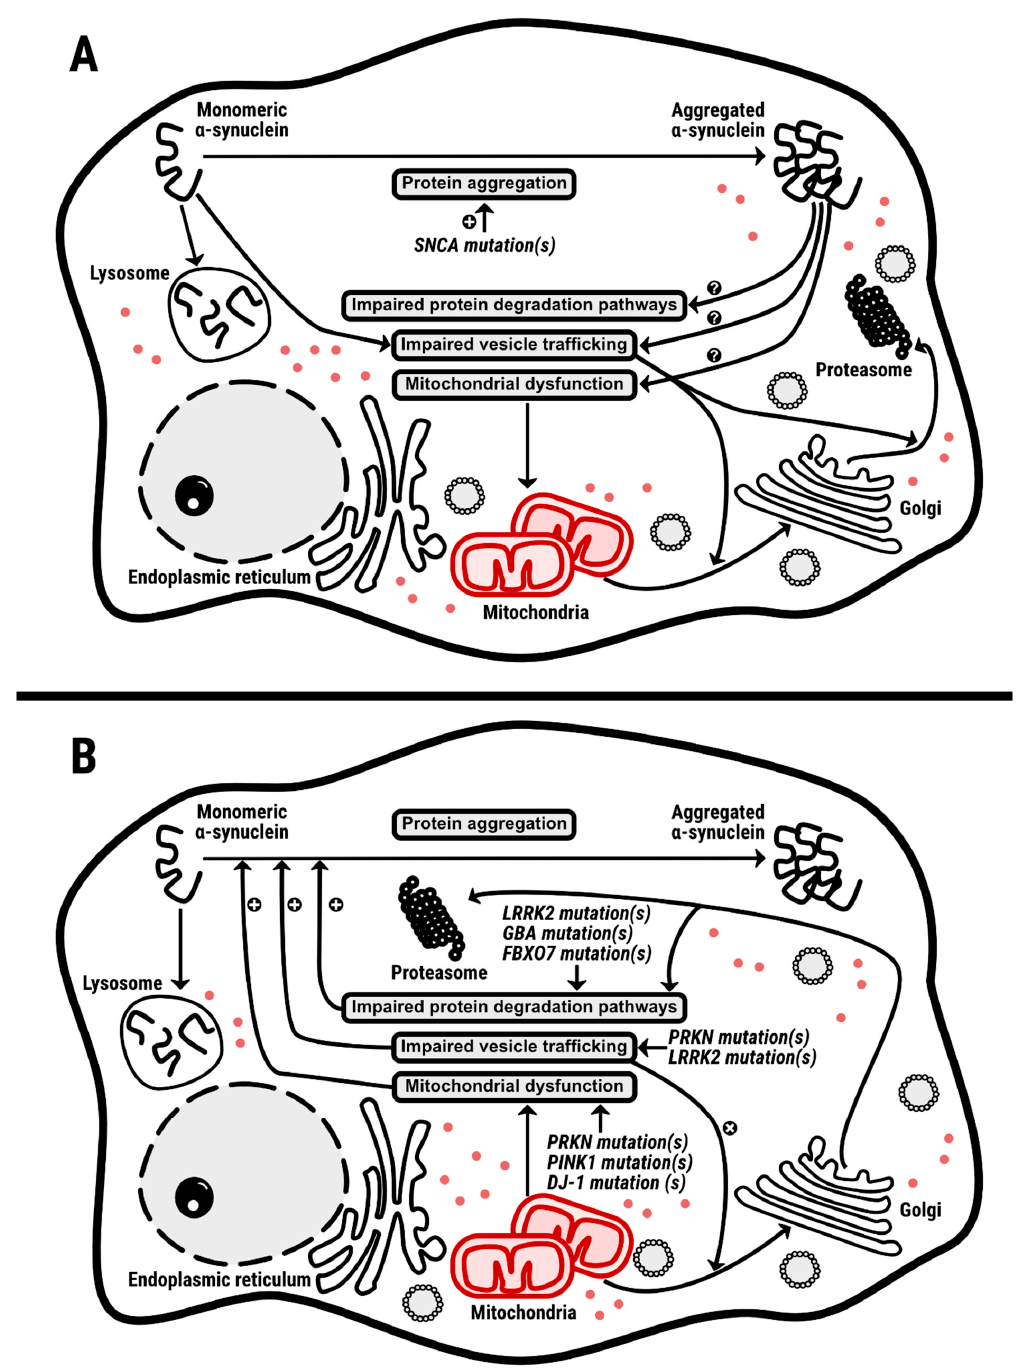
Figure 3. Mechanisms of dyshomeostasis of dopaminergic neurons. Panel ( A ). Mutations in SNCA leads to aggregation of mutated α -synuclein that affects the mechanisms of protein handling and vesicle transport, thus dysbalancing mitochondrial dynamics and function. Panel ( B ). Mutations in genes that affect protein processing, vesicle transport and mitochondrial function leads to aggregation of non-mutated α -synuclein. Red dots represent ATP molecules, mainly synthesized in the mitochondria of neurons, that are needed for all the processes depicted in the